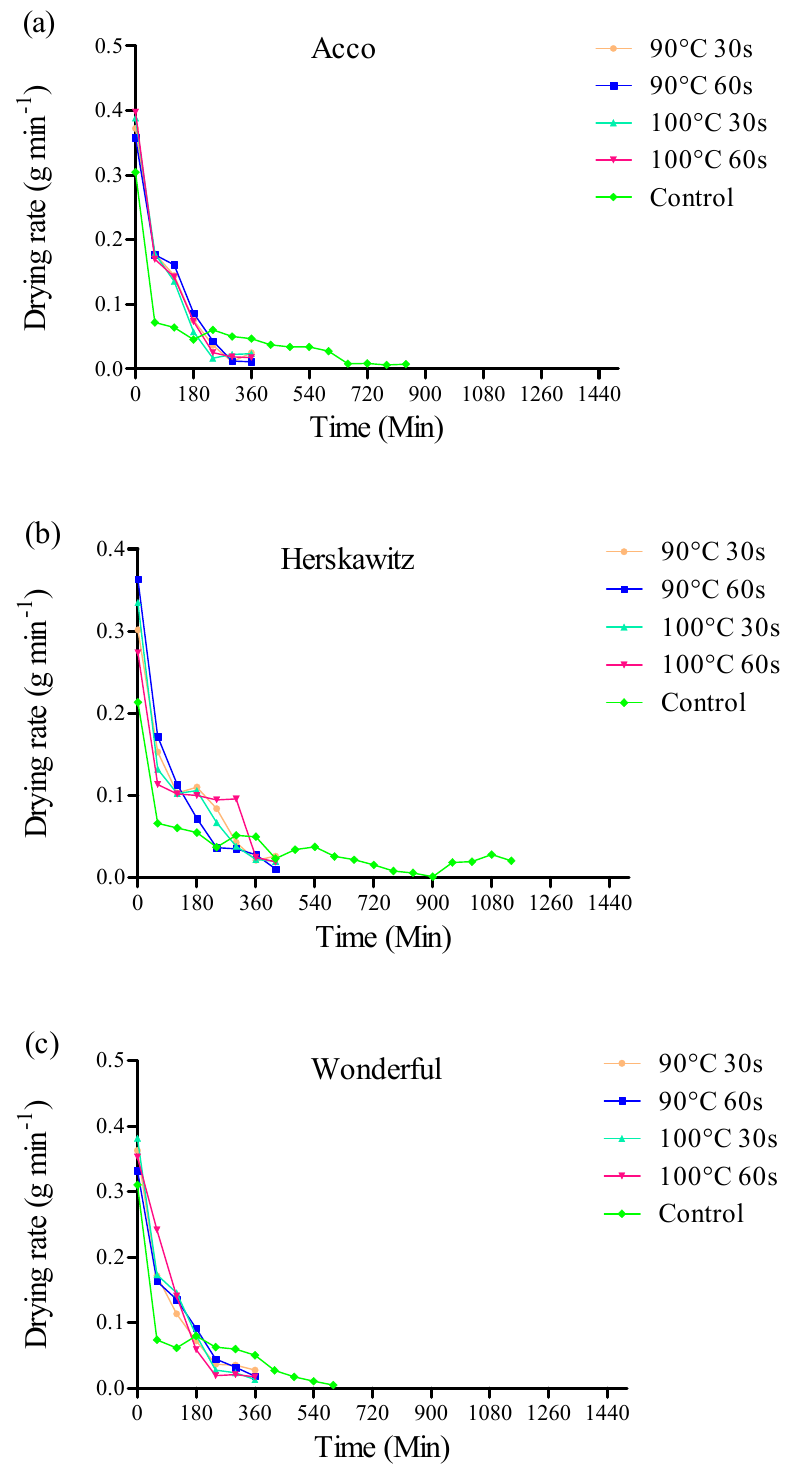
Figure 5. Drying rate versus drying time of pomegranate arils for cultivars (a) Acco, (b) Herskawitz and (c) Wonderful at hot-air flow rate of 1 m s − 1 , temperature condition 60 °C and 19.6% RH.